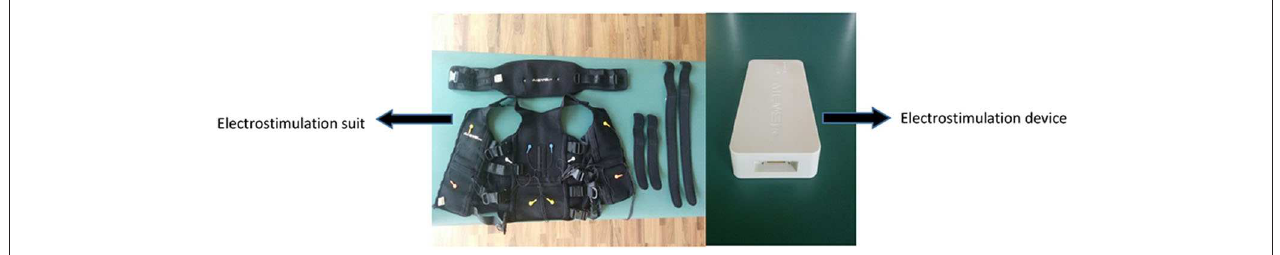
FIGURE 2 | Wiemspro suit and device